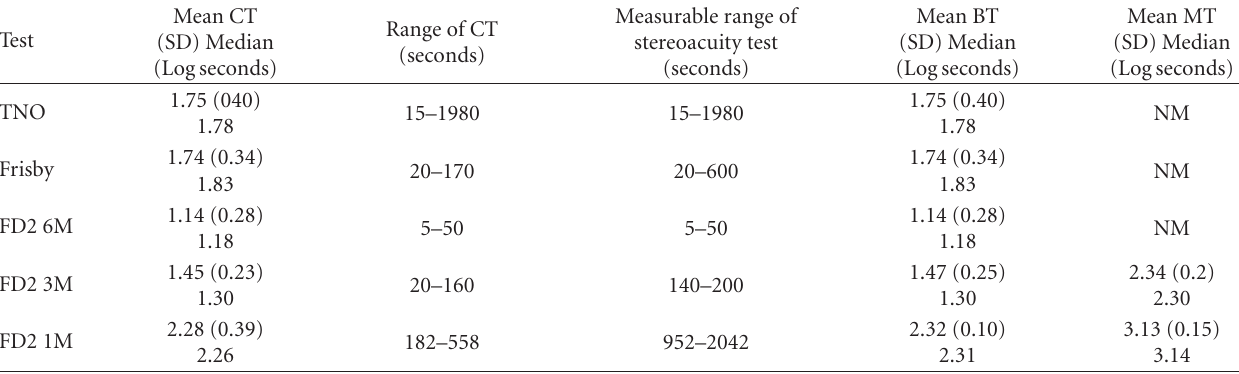
Table 1: Depth discrimination thresholds of control subjects using the near stereoacuity tests, Frisby, TNO, and the FD2 at 1m, 3m, and 6m. Combined (CT), monocular (MT), and binocular (BT) depth discrimination thresholds. Mean, standard deviation (SD) and